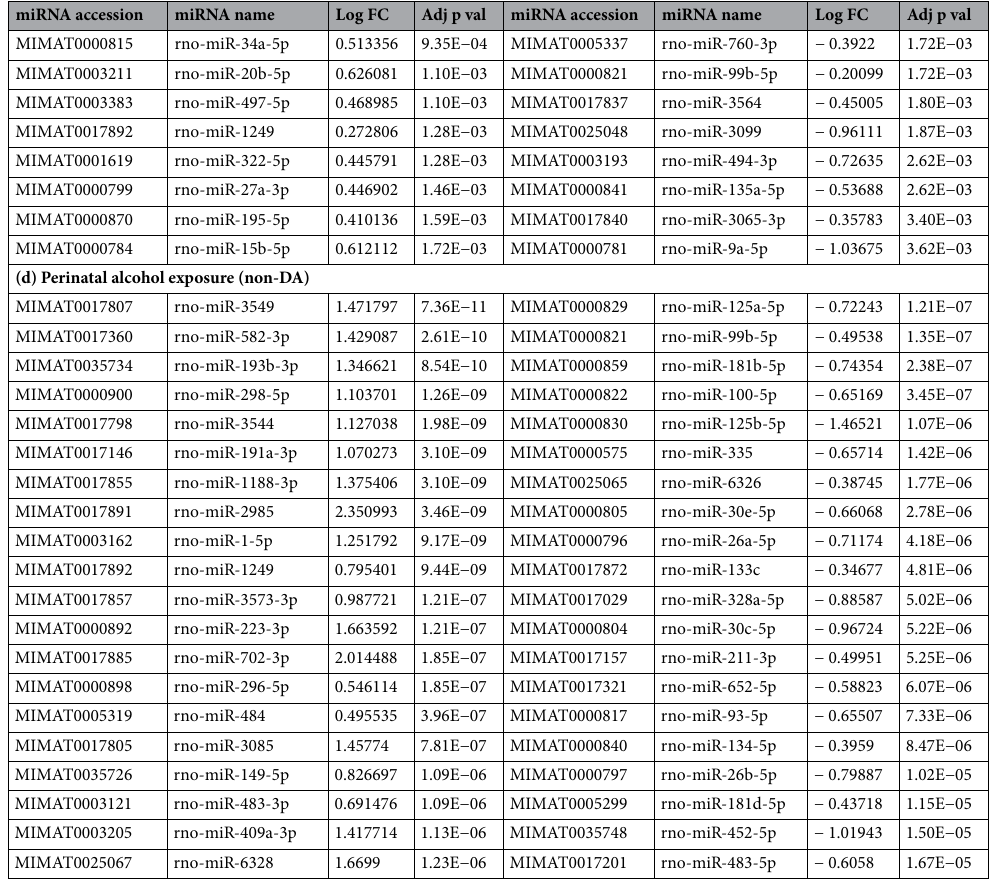
Table 1. Leading 20 most significantly DEmiRs. Following perinatal (a) nicotine-alcohol on DA neurons, (b) nicotine-alcohol on non-DA neurons, (c) alcohol on DA neurons, and (d) alcohol on non-DA